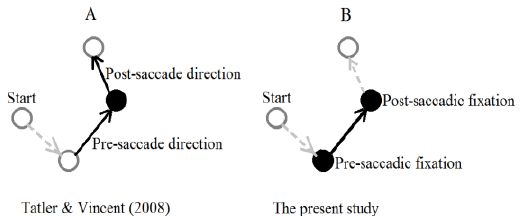
Figure 1. Schematic of a sequence of four fixations, denoted by circles, with arrows representing saccade direction between fixations. The solid black circles and solid arrows are of concern to the two studies shown . Panel A shows that Tatler and Vincent (2008) were concerned about pre- and post-sacade changes in direction on fixation duration. Panel B shows that the concern of the present study was pre- and post-saccadic fixation durations with an intervening